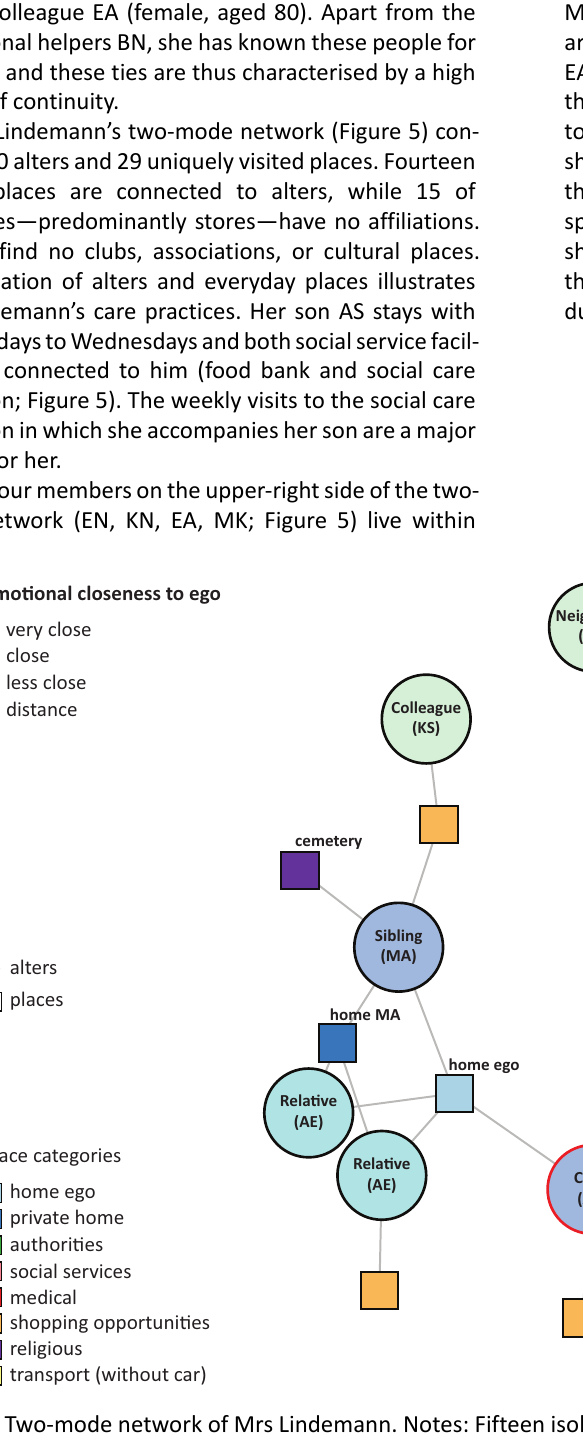
Figure 5. Two‐mode network of Mrs Lindemann. Notes: Fifteen isolated places not shown; places are depicted as squares and annotated when they are mentioned in the analysis; alters are depicted by circles, their emotional closeness to ego is indicated by node colour, and conflictual relationships with ego are indicated by red node frames; ties between alters and places indicate that ego and alter meet at these places or they visit them together according to ego’s account; layout based on the Fruchterman‐Reingold algorithm. Own